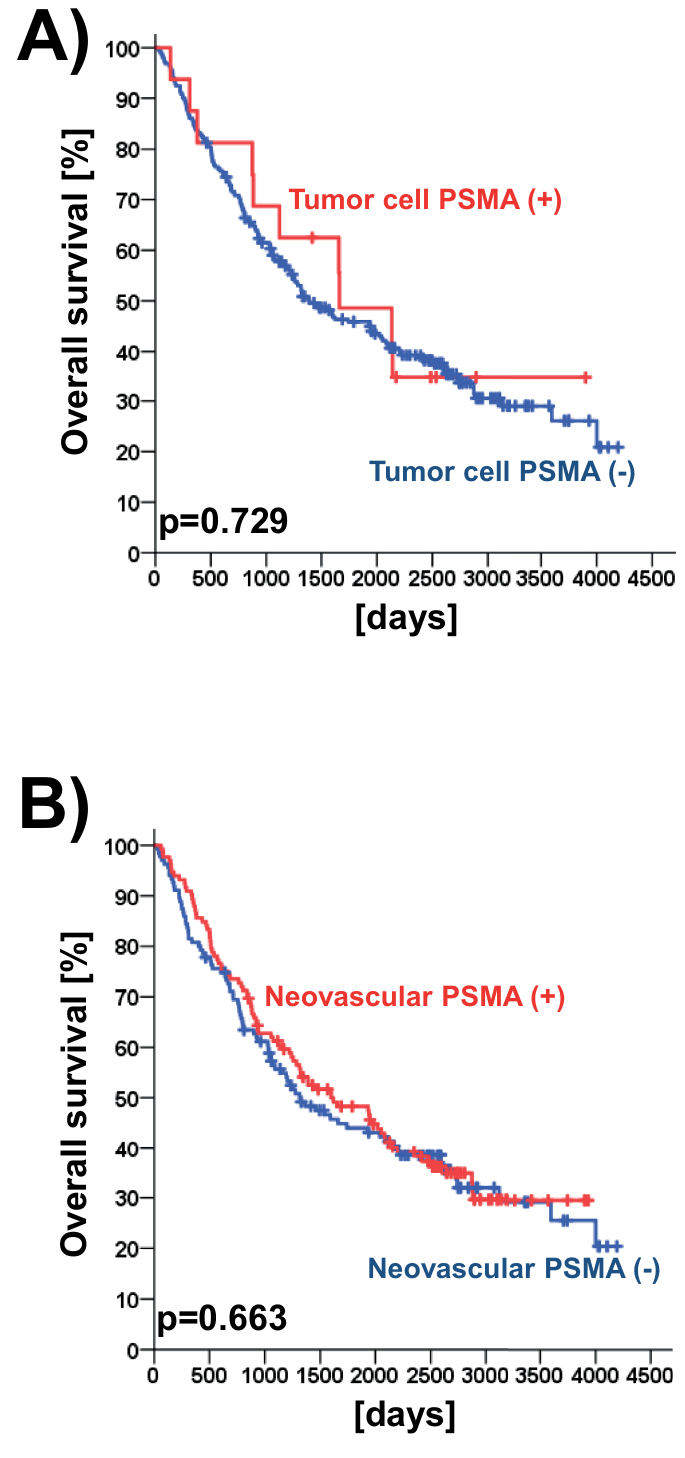
Fig 2. Prognostic impact of PSMA expressionin non-small cell lung cancer (NSCLC). Univariate prognostic models are shown for the immunohistochemicalstaining results (Fig 2A). Likewiseprognostic models are given for neovascular PSMA expressionof all patients as detected by immunohistochemistry (Fig 2B).